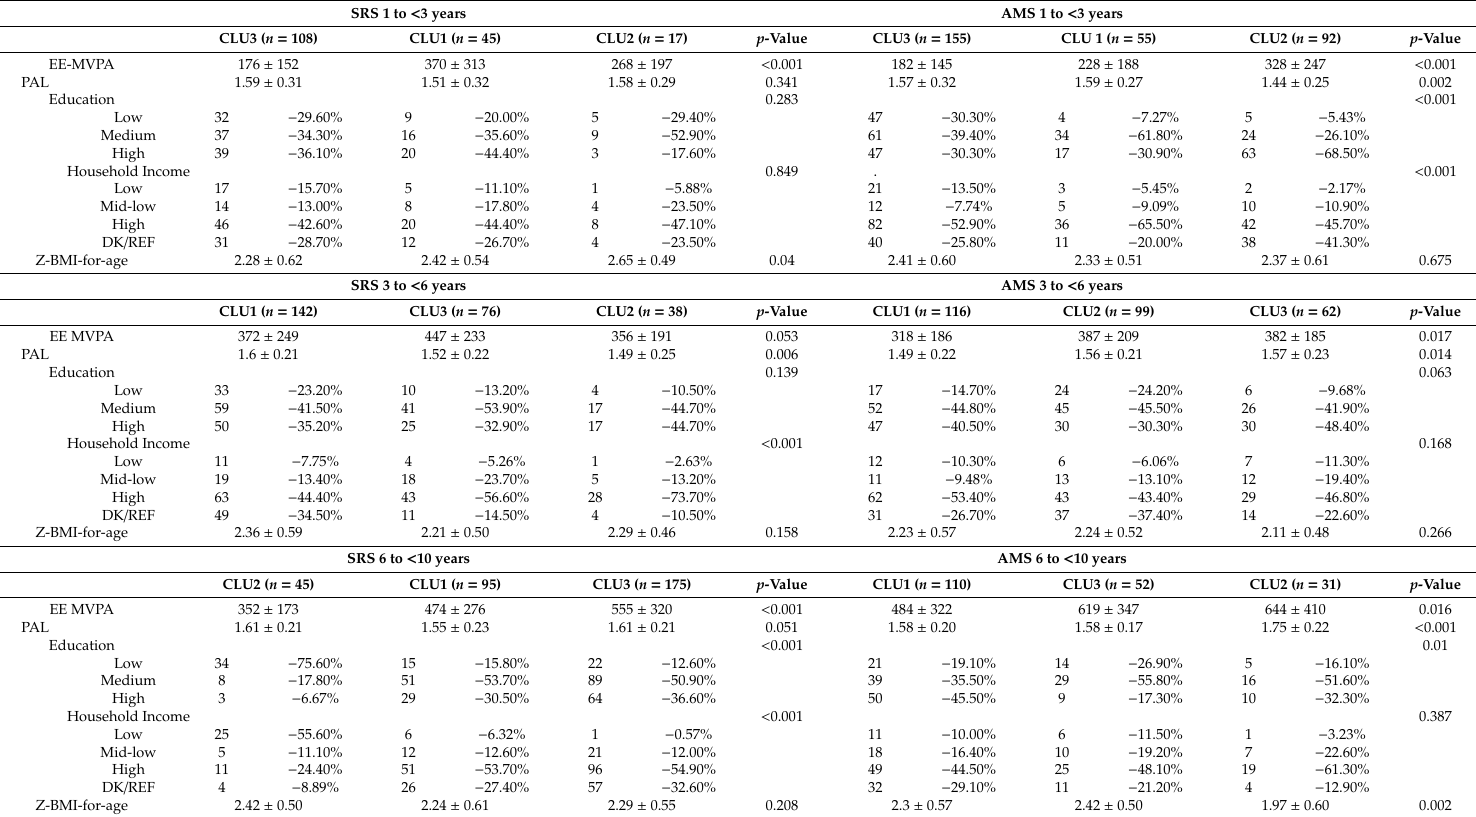
Table 4. Descriptive characteristics of the clusters (CLU) of EsNuPI children by lifestyle and sociodemographic factors in SRS and AMS (dietary factors di ff ered significantly across the